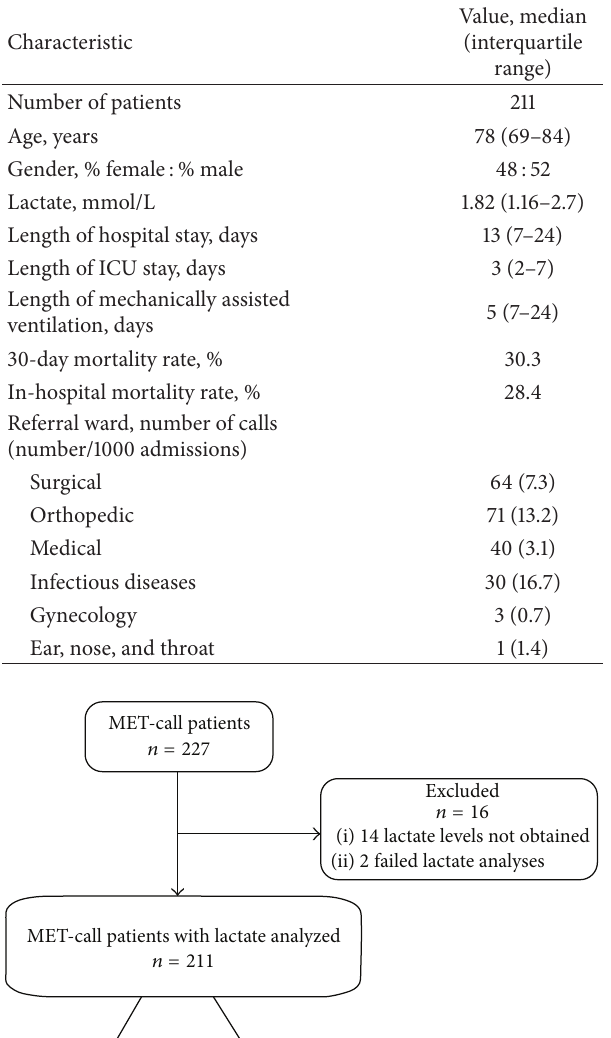
Table 1: Characteristics of patients subject to a Medical Emergency Team- (MET-) call.